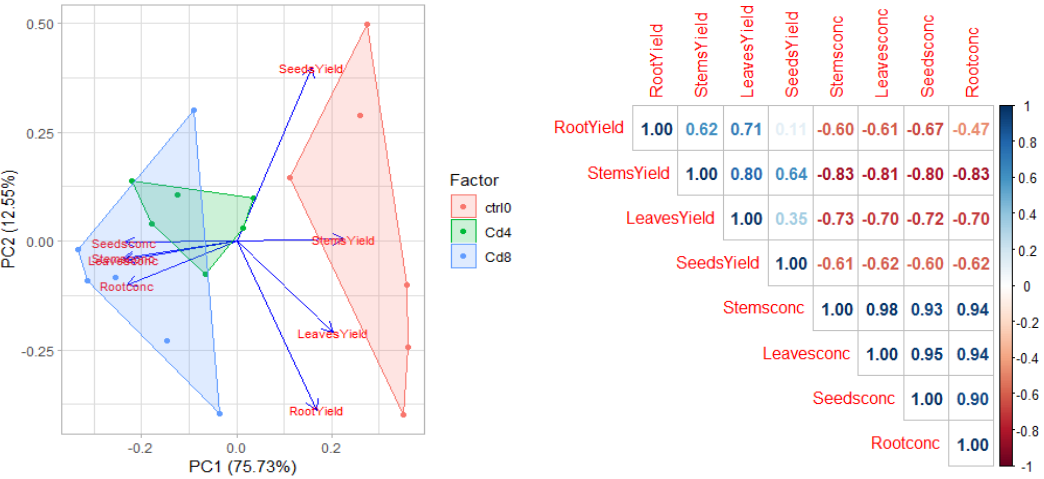
Figure 7. Principal component analysis and correlation matrix in cadmium-contaminated soil in the two years.